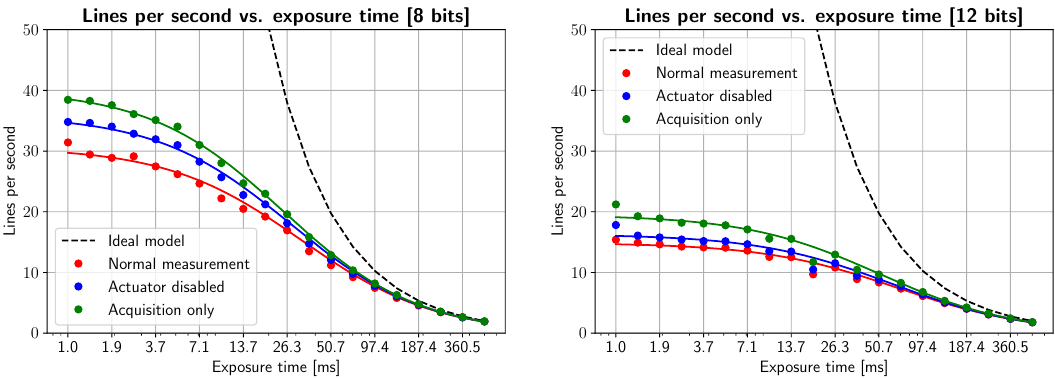
Figure 6. Acquisition speed (in lines per second) as a function of exposure time, disabling different parts of the imaging equipment. Measurements correspond to the colored scatter plots, while a nonlinear least-squares fit is superimposed as a continuous line plot for each scenario. As expected, disabling the scanning system and ignoring buffer copying allows us to reach the theoretical limit of the camera (40–50